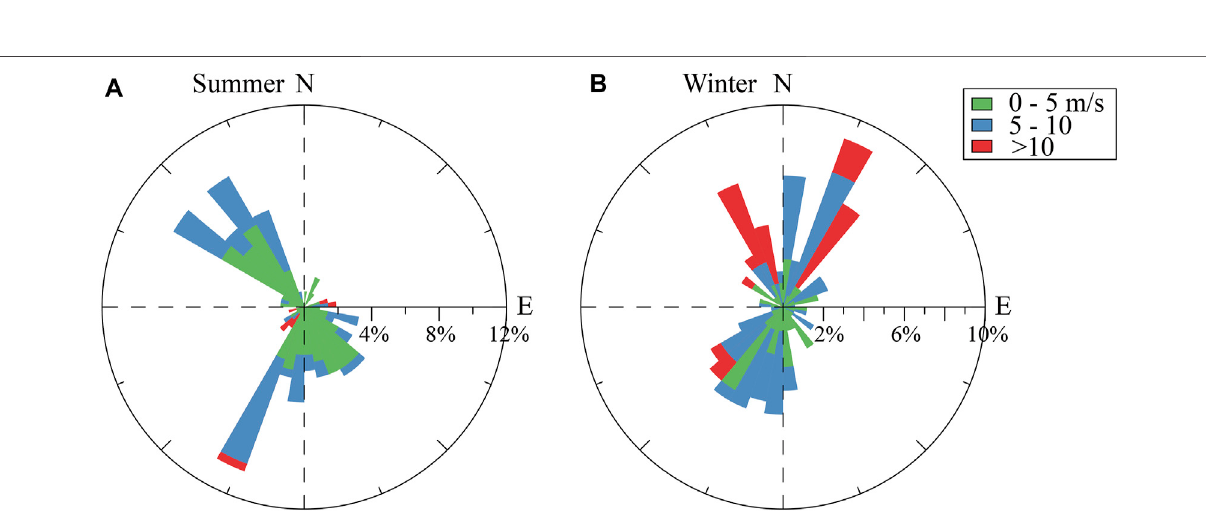
Frontiers in Earth Science |